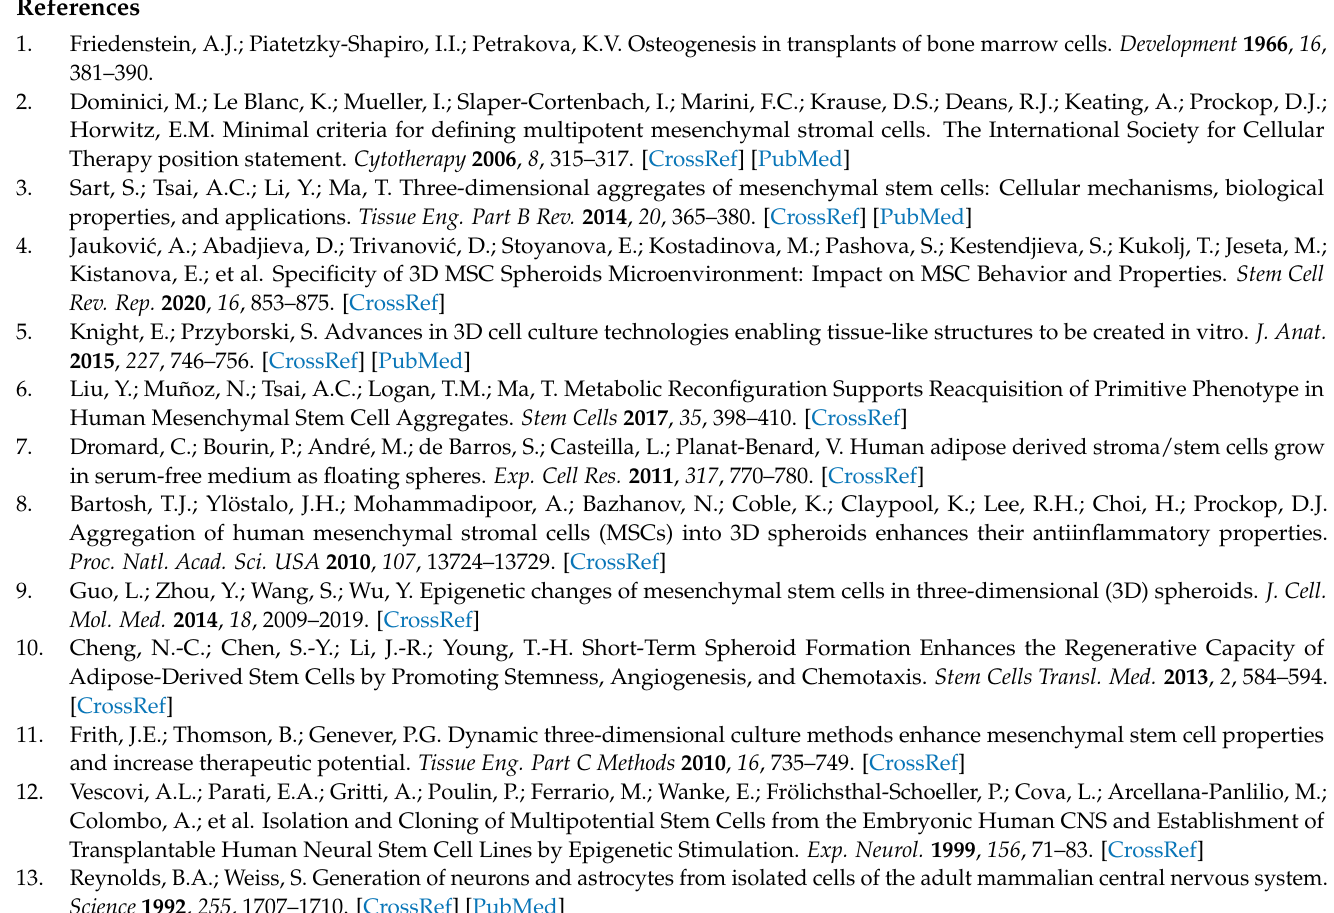
in WJ-MSC spheroid, Table S4: Relative gene expression level quantitative data. Figure S3: Extended analysis for relative gene expression level (fold change, mean ± SD) of neural and pluripotency phenotype in 2D and 3D WJ-MSC. Table S5: Relative gene expression level quantitative data for RNA collected directly from free floating